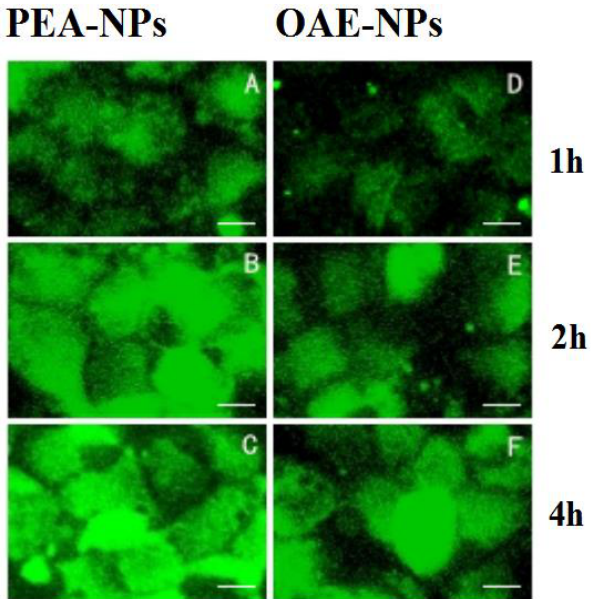
Figure 6. CLSM images of Caco-2 cells treated with FITC labeled PEA-NPs or OAE-NPs: 1 h ( A , D ), 2 h ( B , E ) and 4 h ( C , F ); scale bar represents 25 μm.